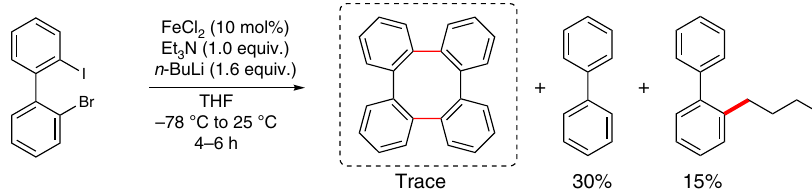
Figure 2 | Serendipity induced the discovery of iron-catalysed cross-coupling of organolithium compounds. Dimerization of 2-bromo-2 0 -iodo-1, 1 0 -biphenyl to synthesize tetraphenylene via a one-pot iron-catalysed intramolecular cross-coupling protocol.